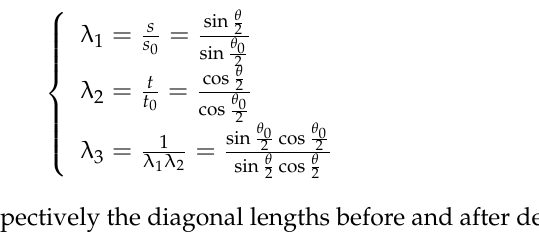
Figure 6. Comparison of numerical and experimental results: ( a ) deformation process; ( b ) princi- pal stress versus morphing angle curves; ( c ) pie graphs of the configuration errors.